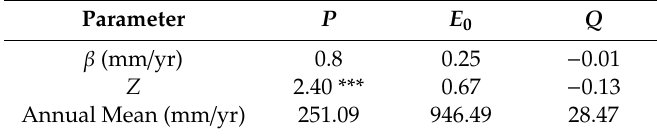
Table 2. Summary of trend analysis for hydro-meteorological series.